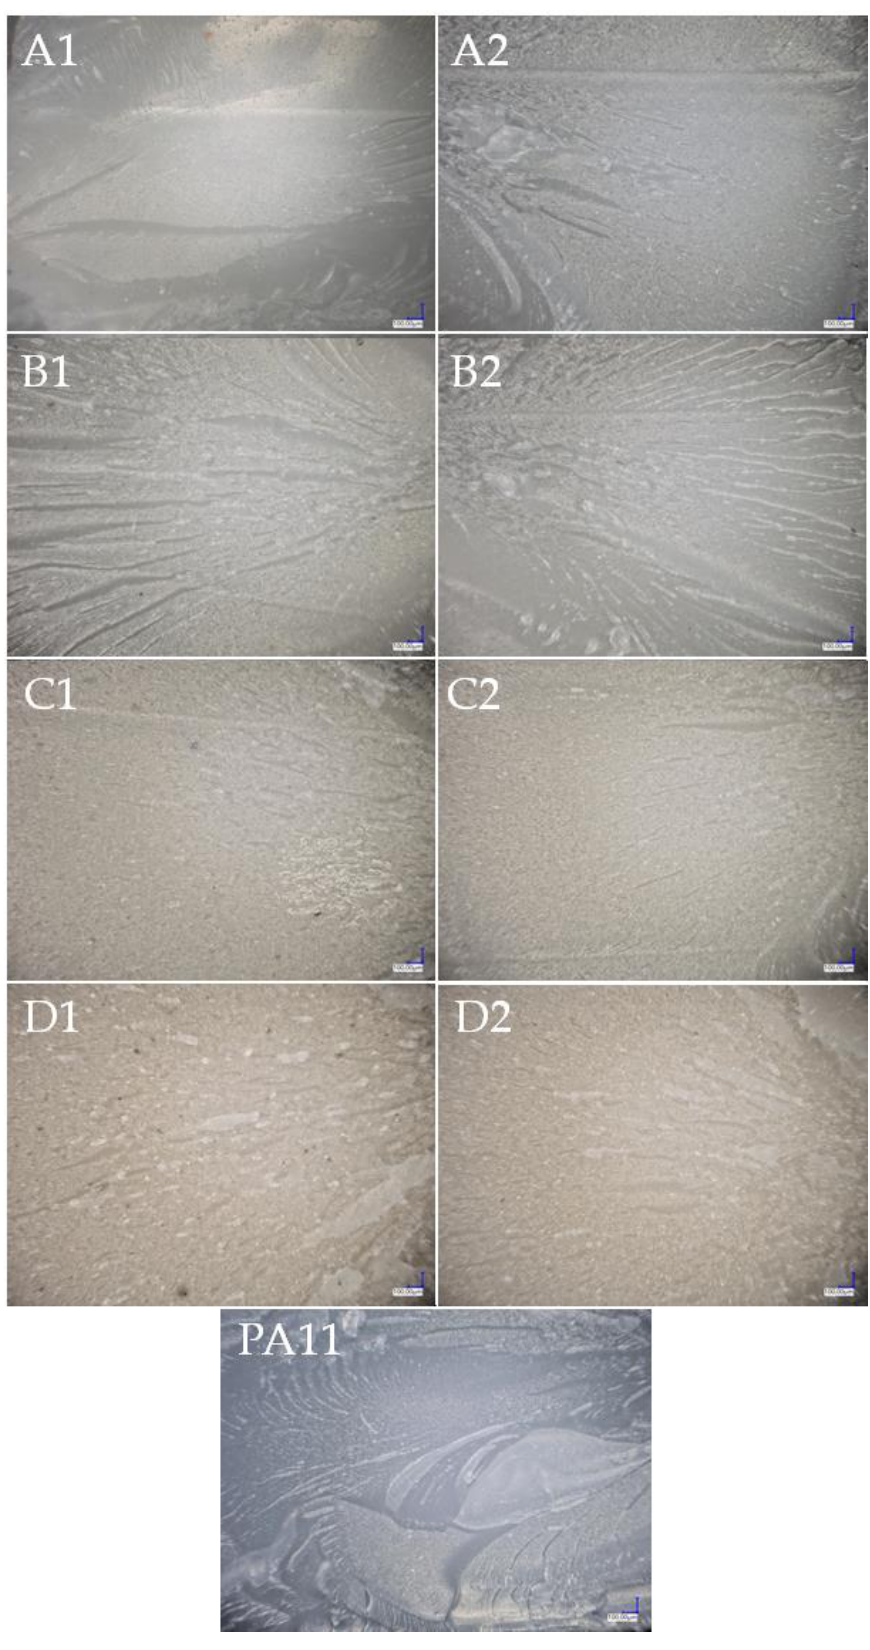
Figure 20. Fractures of the composites after the notch impact test; ( A1 )—2.5OBS, ( A2 )—2.5OFS, ( B1 )—5OBS, ( B2 )—5OFS, ( C1 )—10OBS, ( C2 )—10OFS, ( D1 )—20OBS, ( D2 )—20OFS, ( PA11 )—Polyamide 11.